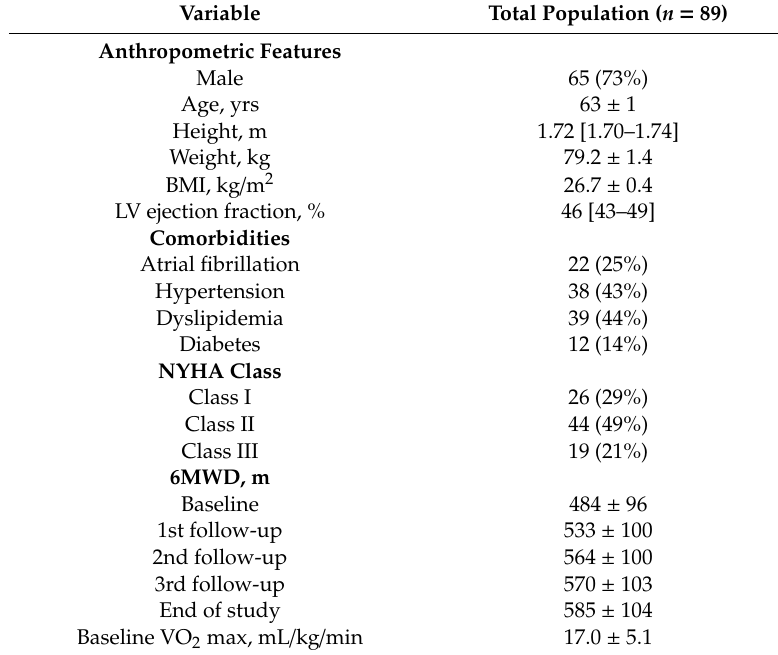
Table 1. Patient characteristics and functional capacity assessed based on 6-min walking distance